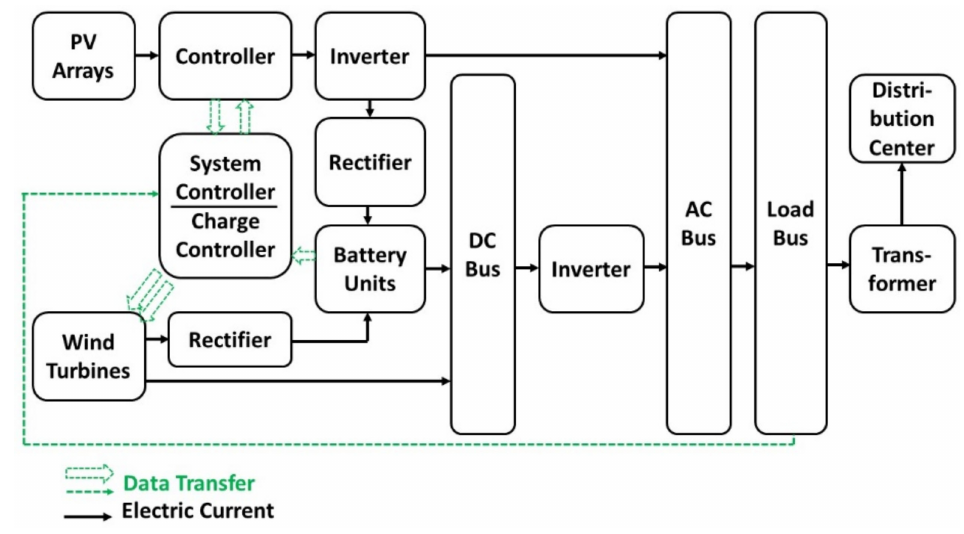
Figure 8. Schematic of FPV + wind energy system and battery storage system